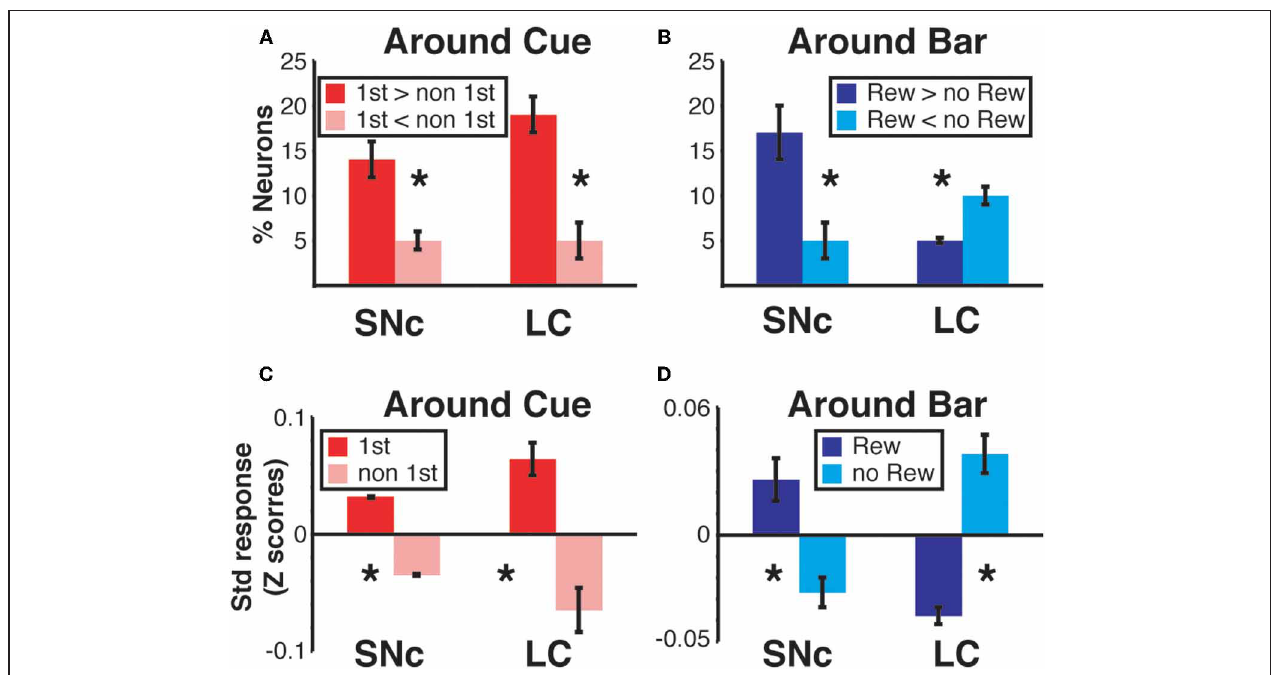
FIGURE 9 | Region specific response modulation. (A) Percentages of SNc and LC neurons displaying a First effect at the beginning of a trial (around cue onset), broken down into neurons for which the response was greater in first trials or greater in non-first trials. In both regions, a majority of neurons were more active in first compared to non-first trials. (B) Percentages of SNc and LC neurons displaying a Reward effect at the end of a trial (around bar release), broken down into neurons for which the response was greater in rewarded trials or greater in unrewarded trials. In the SNc, most of the neurons displaying a reward effect were more active in rewarded trials. In the LC, a majority of the neurons showing a Reward effect were more active in